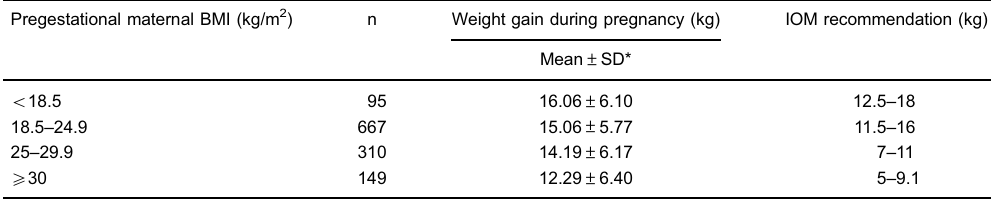
Table 2. Maternal weight gain during pregnancy according to pregestational maternal BMI. BRISA Cohort, Ribeirão Preto, 2010. Pregestational maternal BMI (kg/m 2 ) n